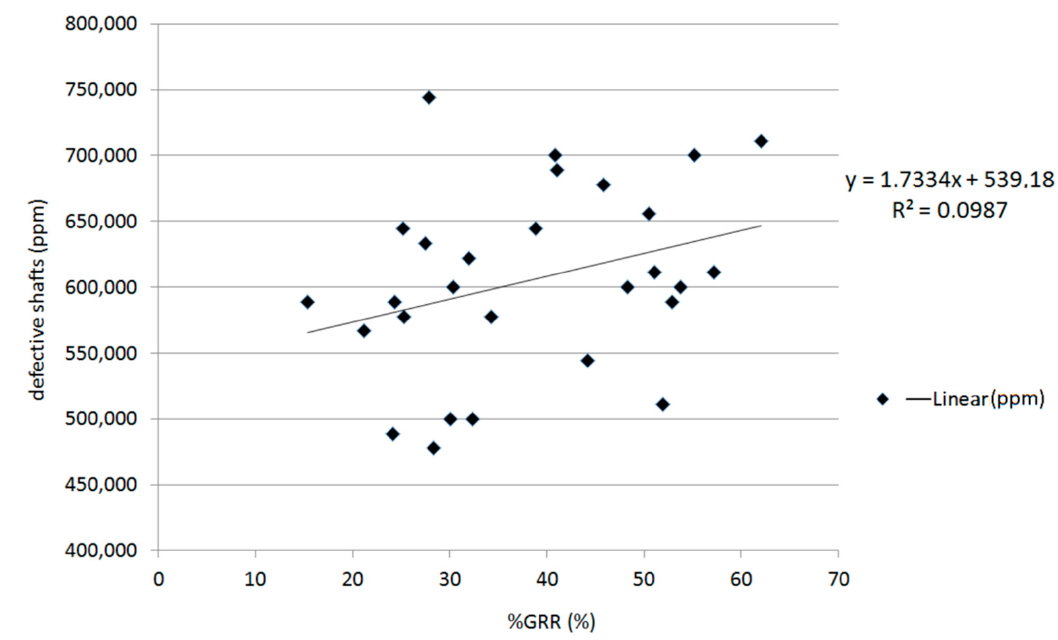
Figure 6. Relationship between %GRR and defective shafts (ppm).